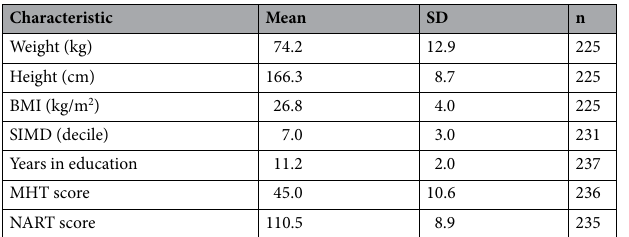
Table 1. Summary statistics for participant characteristics; weight (kg), height (cm), body mass index (BMI; kg/m 2 ), adult socioeconomic status (Scottish Index of Multiple Deprivation decile; SIMD), number of years spent in education and childhood (Moray House Test (MHT) score) and adult (National Adult Reading Test (NART) score) cognitive ability.